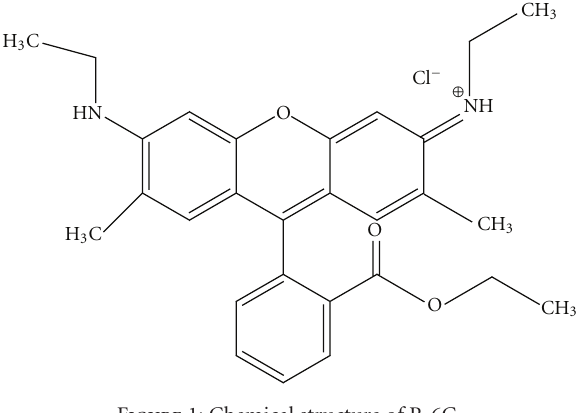
Figure 1: Chemical structure of R 6G.